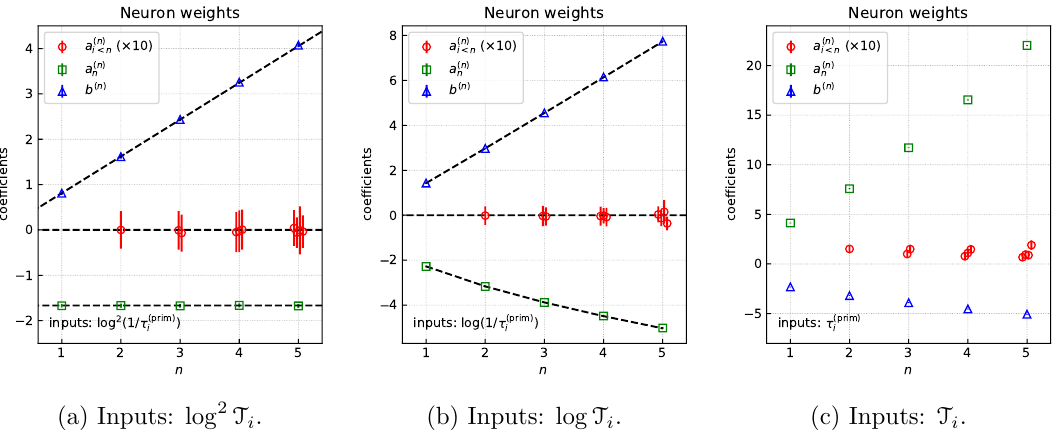
Figure 3 . Perceptron parameters after training. When available, expected analytic results are shown as dashed lines.